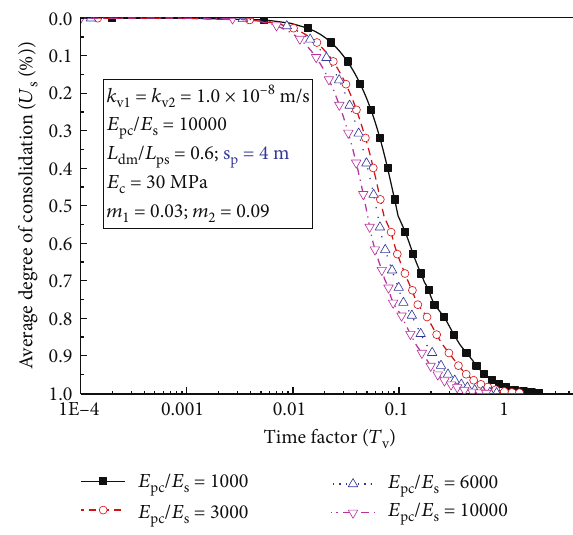
on the consolidation rate. 2